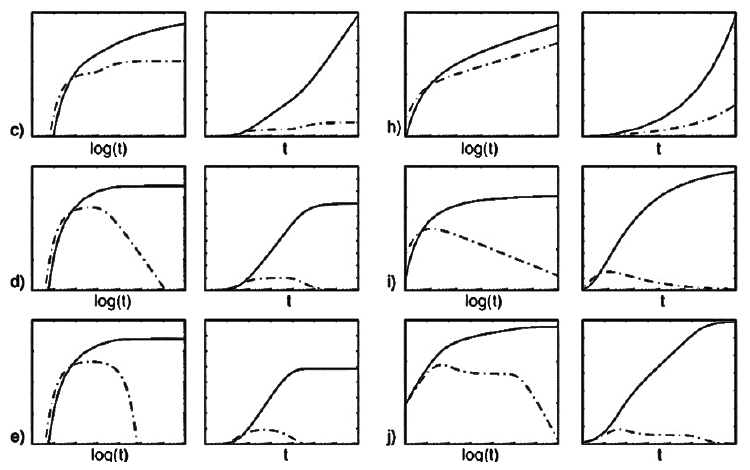
Figure A1. ( a ) Theis model: infinite two-dimensional confined aquifer; ( b ) double porosity or unconfined aquifer; ( c ) infinite linear no-flow boundary; ( d ) infinite linear constant head boundary; ( e ) leaky aquifer; ( f ) well-bore storage and skin effect; ( g ) infinite conductivity vertical fracture; ( h ) general radial flow—non-integer flow dimension smaller than 2; ( i ) general radial flow—noninteger flow dimension larger than 2; ( j ) combine effect of well bore storage and infinite linear constant head boundary.